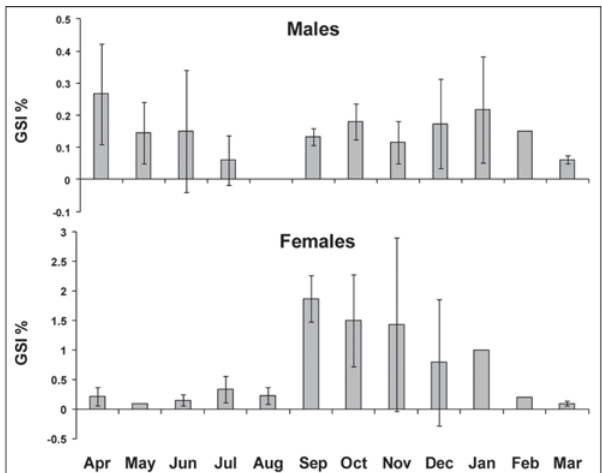
Fig. 5. Means and standard deviations of the Gonadosomatic Indices (GSI) of Cichla kelberi during the collection